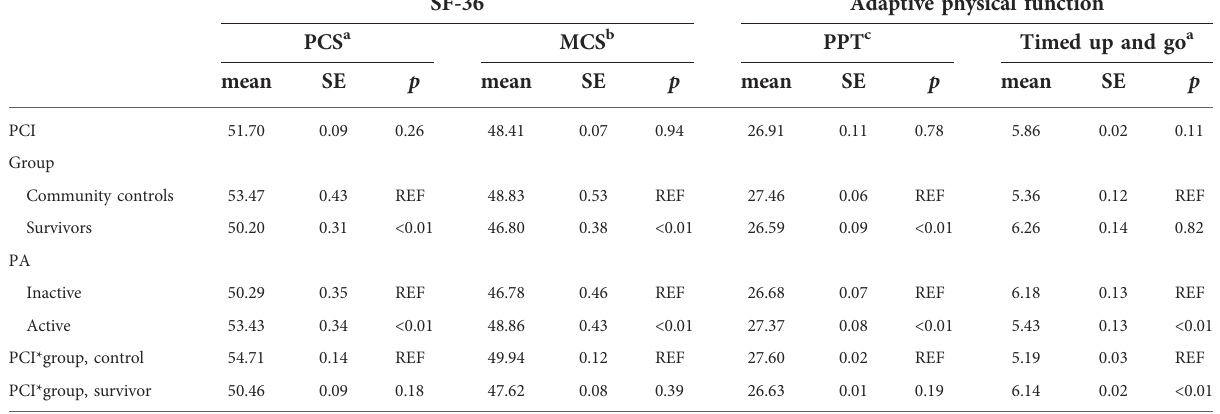
TABLE 4 Associations between the physiological cost index, SF-36 component summaries, and adaptive physical function in adult survivors of acute lymphoblastic leukemia vs. community controls.